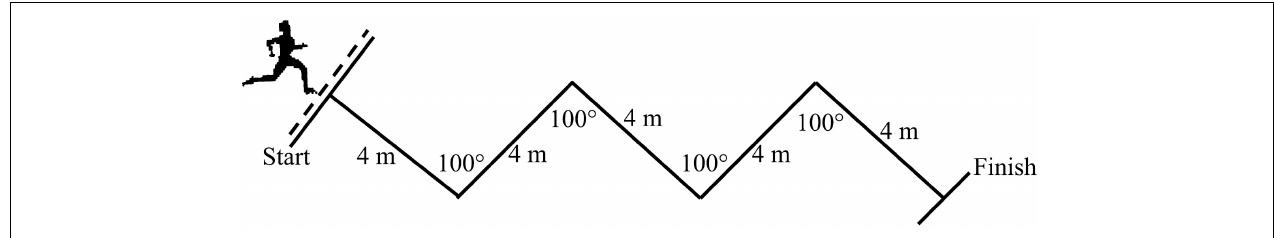
FIGURE 1 | Repeated change of direction test